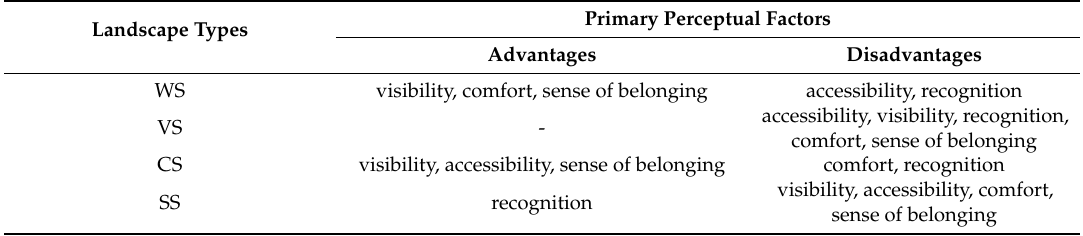
Table 6. Evaluation of the advantages and disadvantages based on CATREG